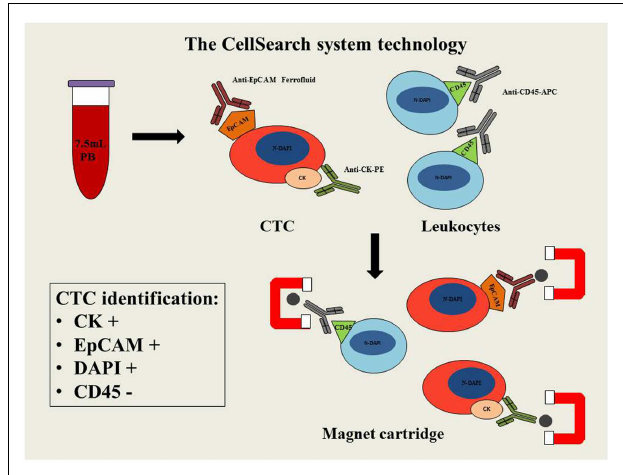
FIGURE 1 | Schematic diagram of CellSearch system technology . PB, peripheral blood; CTC, circulating tumor cell; EpCAM, epithelial cell adhesion molecule; CK–PE, cytokeratins–phytoerythrin; CD45-APC, cluster of differentiation 45-allophycocyanin; N-DAPI, nucleus stained with